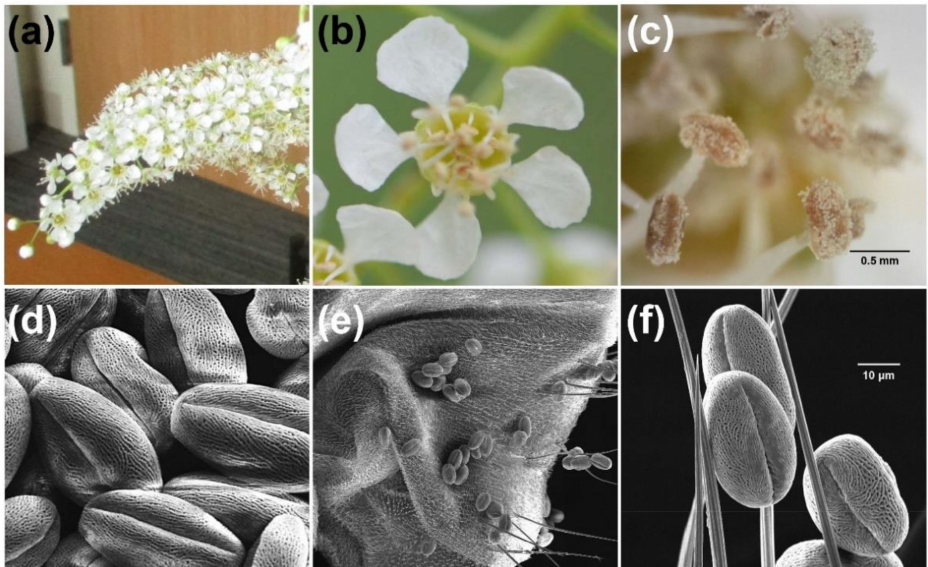
Figure 4. Flowers and pollen grains of black cherry: ( a ) black cherry raceme in full bloom; ( b ) a black cherry flower with 5 white petals and 14–15 stamens surrounding a single pistil; ( c ) anthers after dehiscence; ( d ) SEM image of pollen grains on anther; ( e ) SEM image of black cherry pollen grains found on the thorax of Tipula sp. (Diptera: Tipulidae); ( f ) black cherry pollen grains captured in insect hairs showing the unique exine sculpturing.